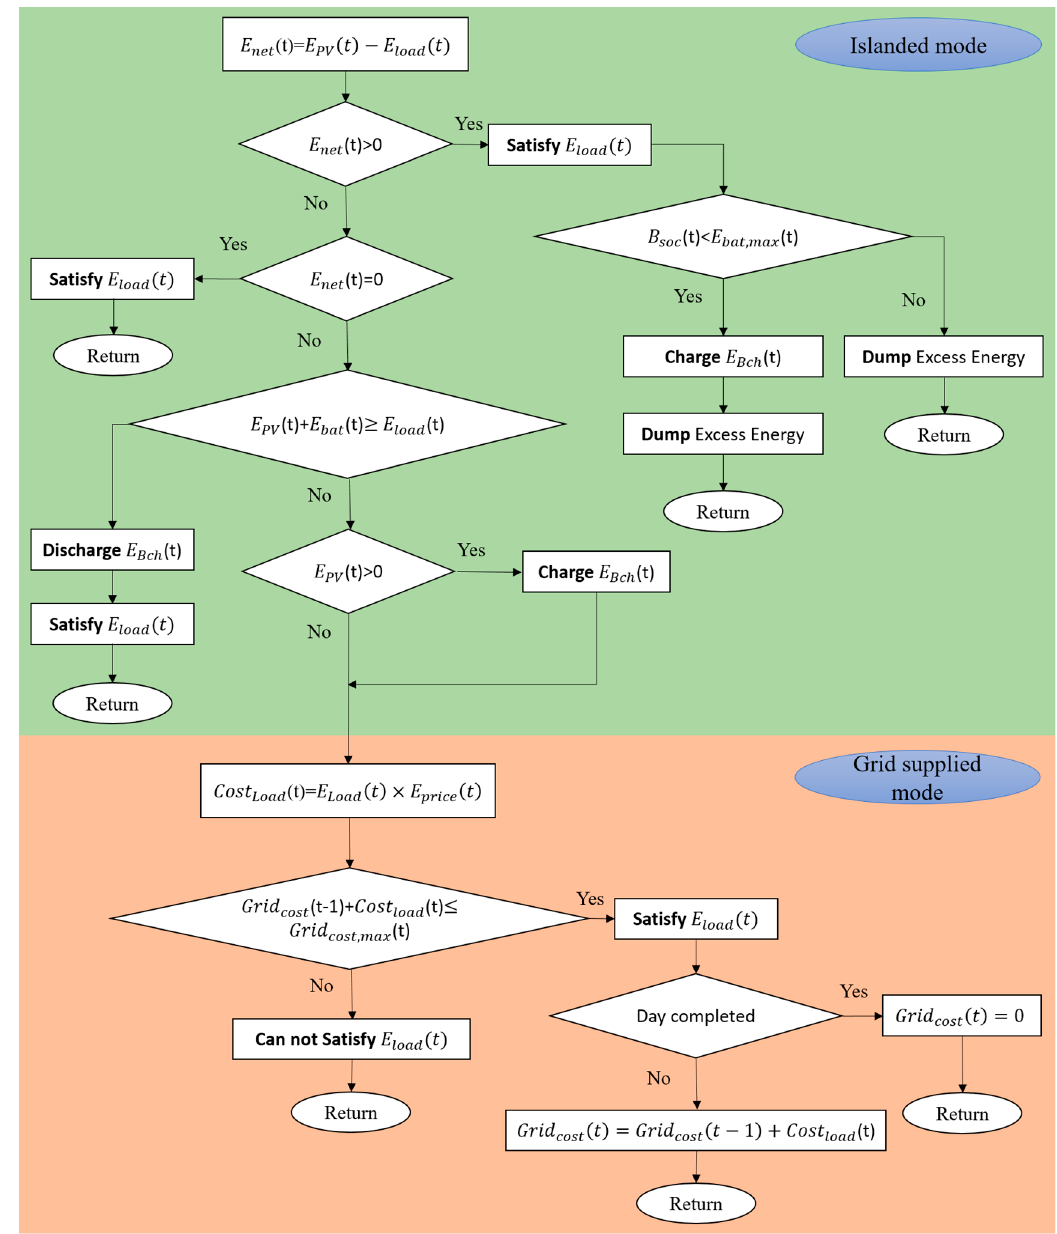
Figure 4. Proposed energy management flowchart.